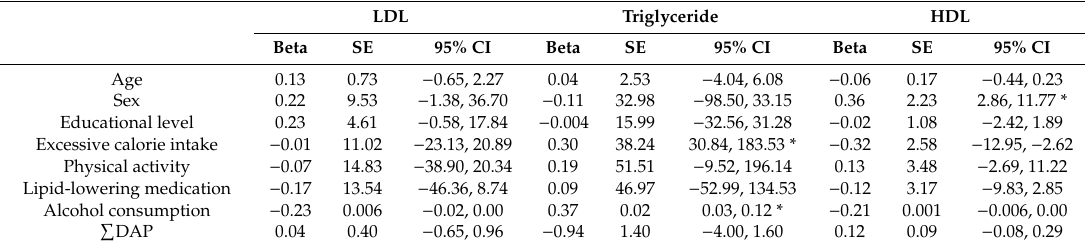
Table 5. Factors associated with lipid levels in sprayers and the general population.